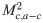
CART association graph.A: Stacked histograms for First Quarter, 2018 ‘Percentage of short-stay residents who were rehospitalized after a nursing home admission’ data for nursing homes with a 1 star or 5 star overall rating; the dashed line is the median value. CART associations between Nursing Home Compare ‘Rehospitalized’ quality measure and ‘1 star, 5 star’ overall rating for IGG and ϕ2 are also shown. IGG was scaled to match ϕ2. Both Mc,a-c2 and ωM were scaled by 1/50. B: Column scaling invariant center-of-mass coordinates, (δc,a−c, μc,a+c), for the two-component proportional variation in the standard one-simplex, △1.